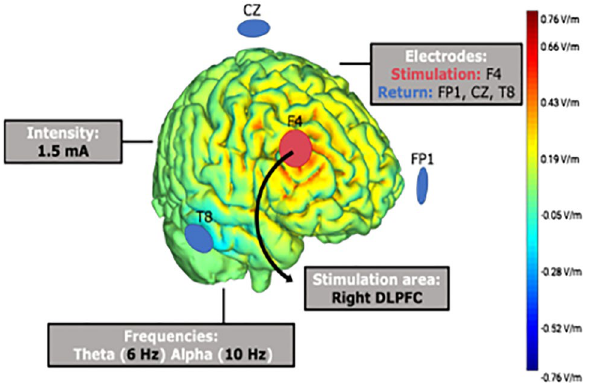
Figure 1. Brain stimulation technique. An illustration of the HD-tACS montage and the simulation of the electric field generated according to the StimWeaver software